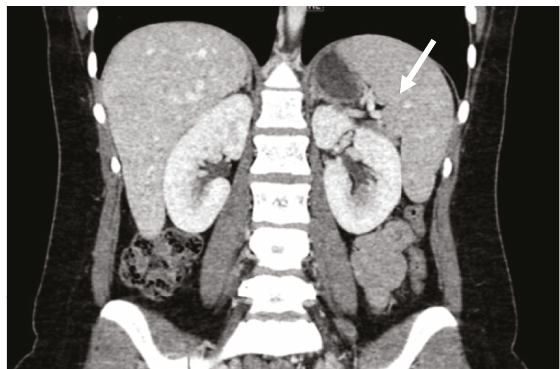
Figure 1: Baseline CT scan shows the normal size and appearance of the spleen before using granulocyte colony-stimulating factor (G-CSF).